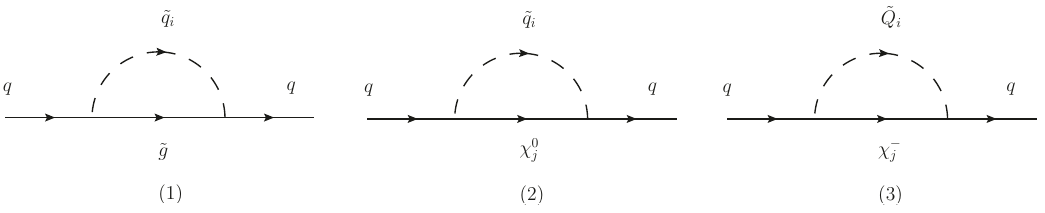
and d g are obtained by attaching a q q